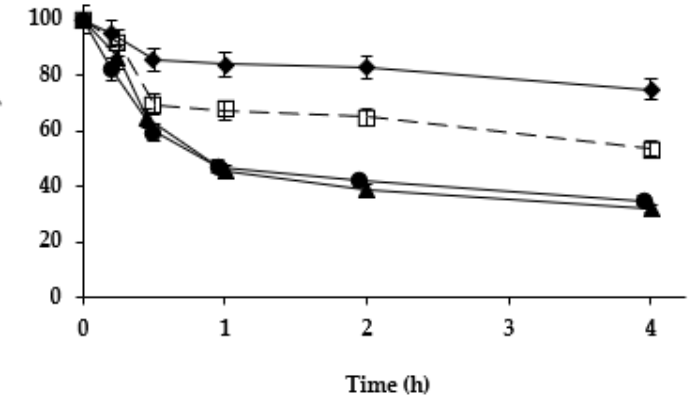
Figure 4. Thermal inactivation courses of different Purolite C18-TLL biocatalysts. Other specifications are described in Methods. Unmodified biocatalyst (open squares and dotted line); biocatalyst modified with ZnCl 2 /sodium phosphate (solid rhombus and solid line); CoCl 2 /sodium phosphate (solid triangles and solid line); CuCl 2 /sodium phosphate (solid circles and solid line).